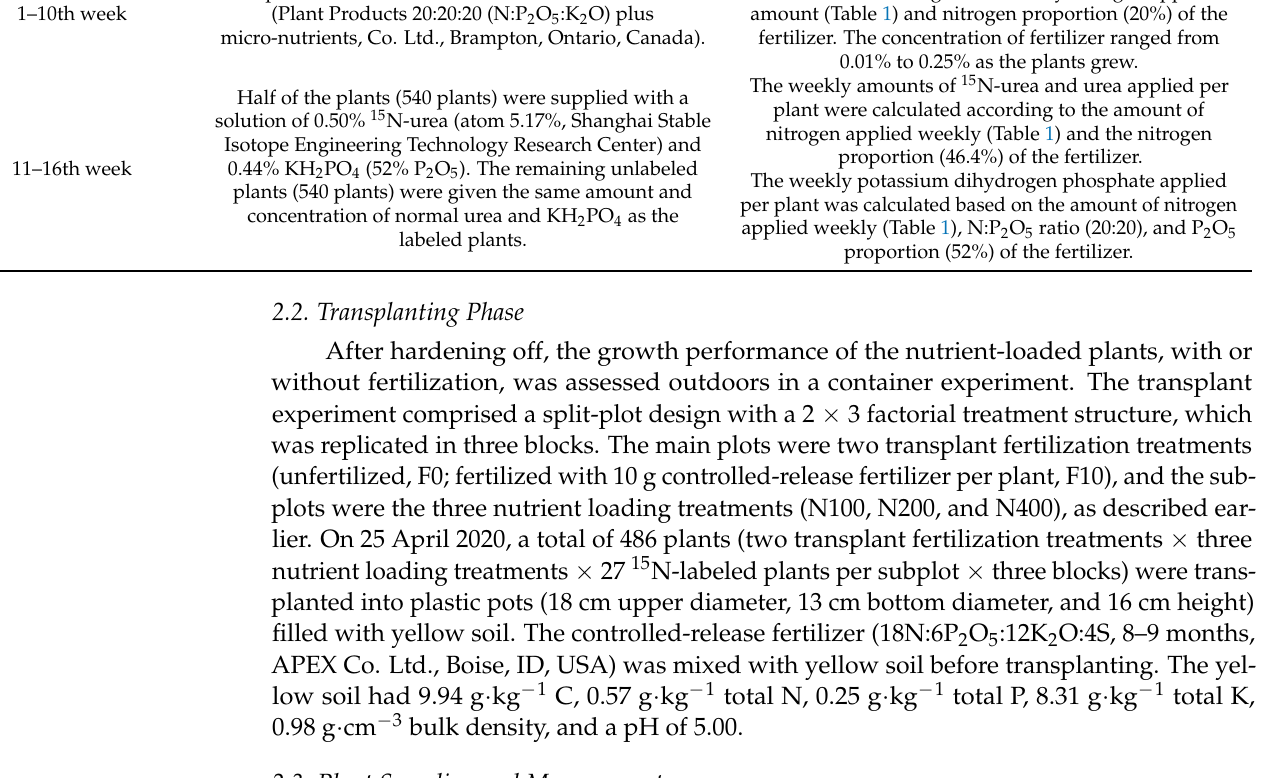
Table 2. Fertilization schedule for nutrient-loaded Betula alnoides plants in the nursery. Week of Fertilization Type of Fertilizer Applied Dose of Fertilizer Applied